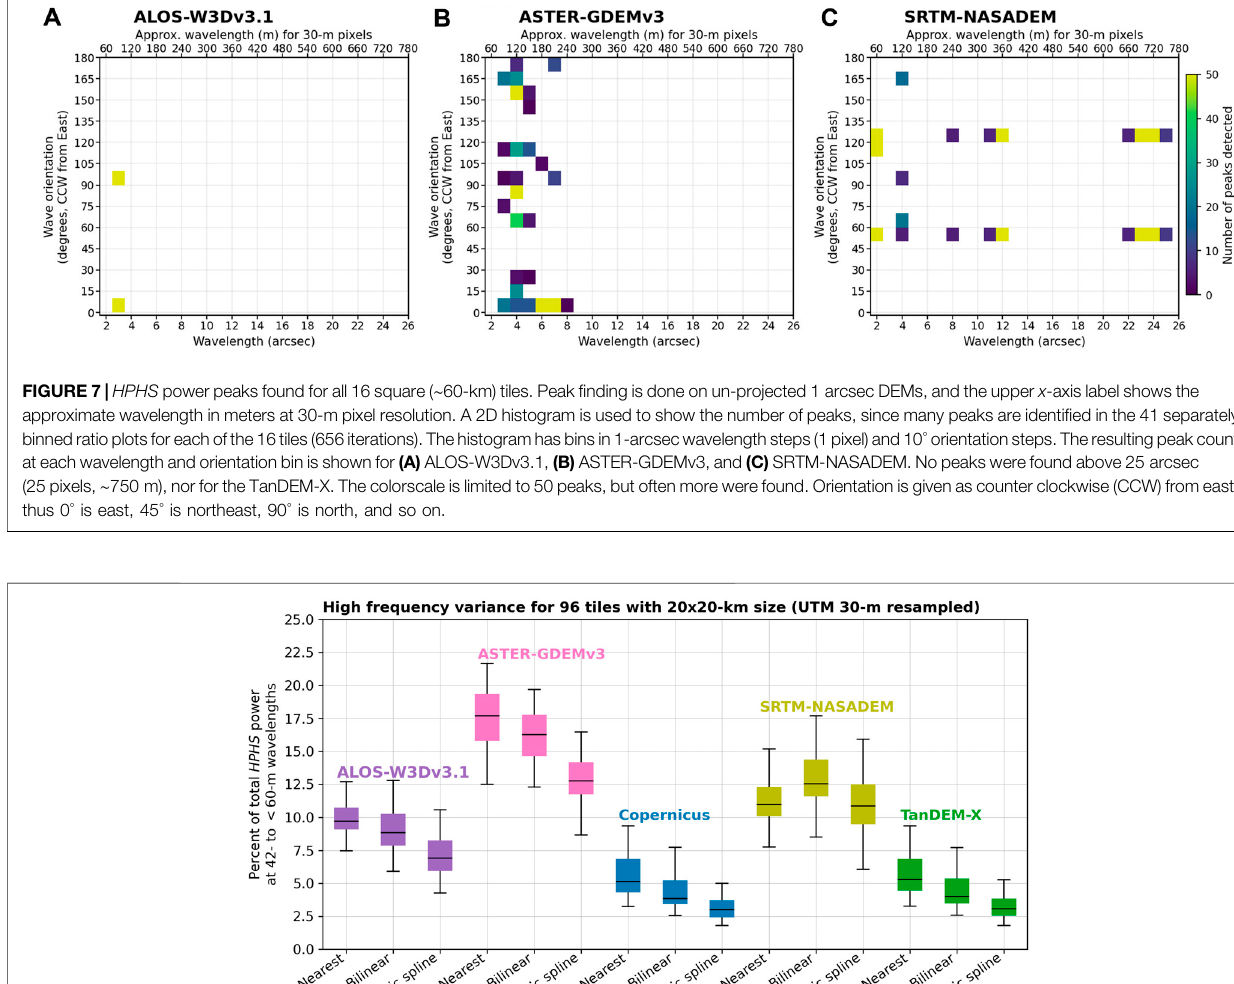
Frontiers in Earth Science |